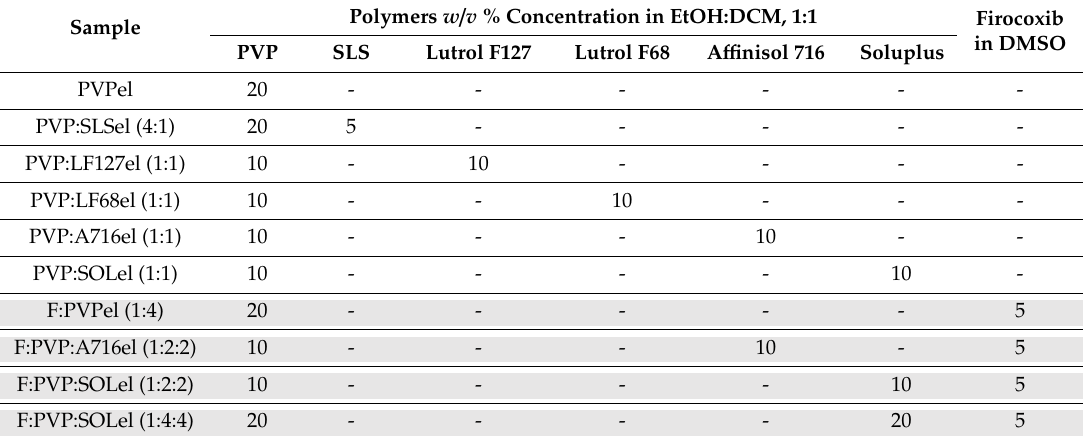
Table 3. Polymeric solutions prepared with and without firocoxib at di ff erent polymer concentrations ( w / v %). The samples of the solutions prepared with firocoxib are reported in the last light grey rows.